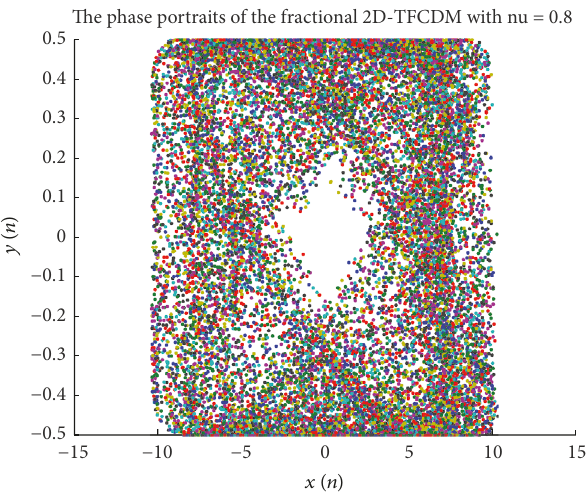
Figure 6: The phase portraits of the fractional 2D-TFCDM for 𝑘 1 = 8 , 𝑘 2 = 0.5 , and ] = 0.8 .